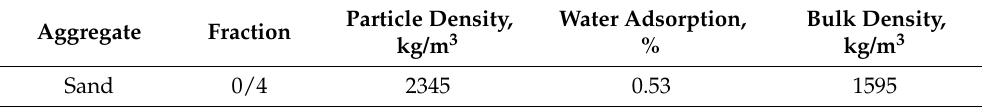
Table 2. Physical properties of sand.